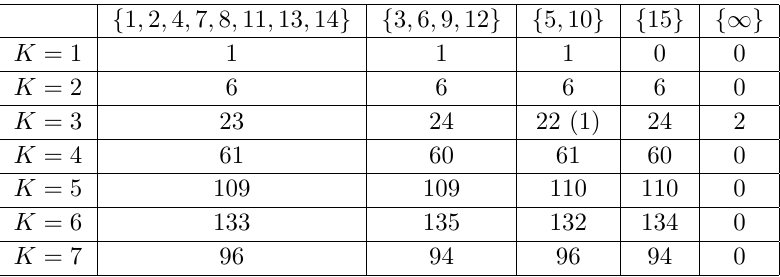
Table 12 . Number of Bethe roots for decomposed BAE with M = 15.